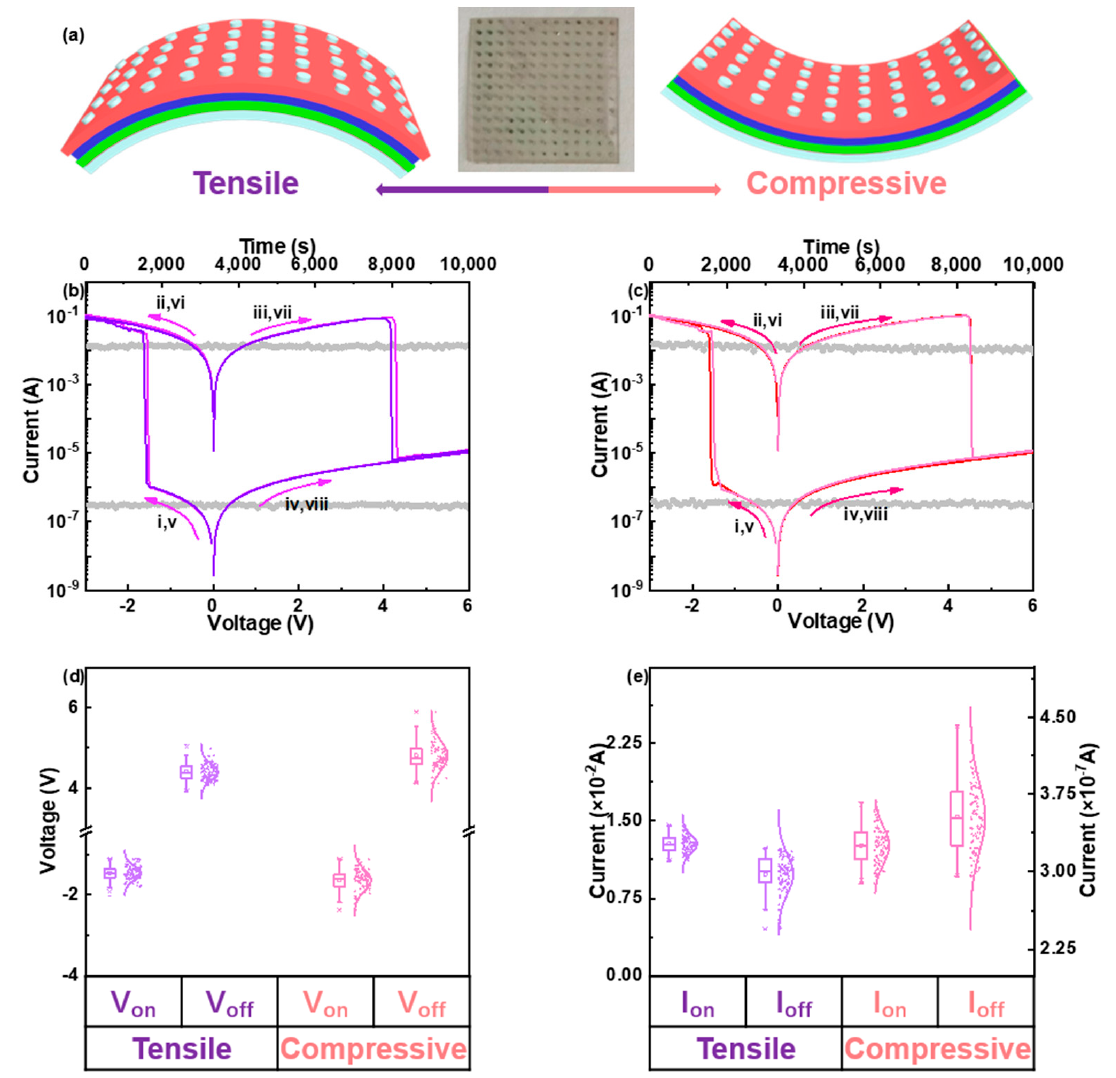
Figure 4. ( a ) Schematic illustration of Al/PDA-PPy 3 Ir/ITO device under tensile and compressive strain; ( b ) I – V curves of the device under tensile strain; ( c ) I – V curves of the device under tensile strain; ( d ) cumulative probability of turn-on and turn-off voltage under tensile and compressive strain; ( e ) cumulative probability of currents at ON and OFF state with applied voltage of − 0.5 V under tensile and compressive strain.